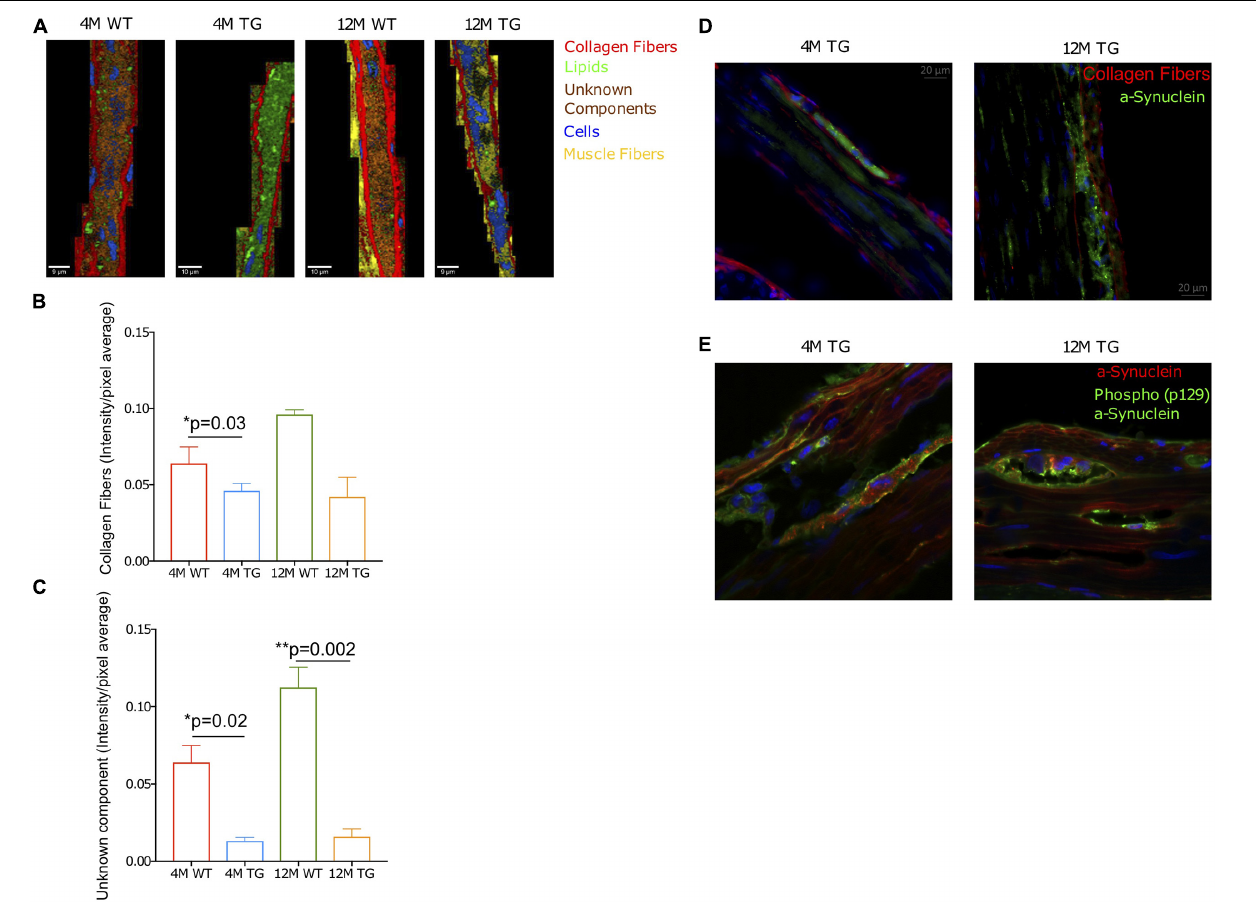
FIGURE 6 | Collagen fibers, unknown component, and phospho- α -Syn in the TG rat colon. (A) Combined representative TCA images of the stained regions. The components were collagen fibers (red), lipids (green), an unknown component (orange), cells (blue), and muscle fibers (yellow). The intensity range was scaled 0–0.8 for all components. (B,C) The bar diagram showed the collagen intensity/pixel average for WT and TG rat colon samples at 4M and 12M age. Averaged intensities per pixel of the collagen fibers and unknown component statistically compared using Student’s unpaired t -test. p -Value represents * p ≤ 0.05. Significant differences were observed in the unknown component between 12M WT and TG ( p = 0.002) as well as between 4M WT and TG 4M ( p = 0.03). In contrary, statistical difference was observed in the collagen fibers only for 4M WT and TG ( p = 0.02). p -Value represents * p ≤ 0.05 and ** p ≤ 0.01. (D) Staining of the colon tissues with α -Syn (green, D37A6), collagen I (red, 113M4774) antibodies, and DAPI for cell nucleus for 4M and 12M TG rats. (E) The detection of phospho- α -Syn (p129; green) and α -synuclein (red, D37A6) and DAPI (blue) in the colon tissues of 4M and 12M TG rats.